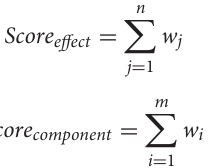
The entropy weight ω j of the index j is defined as: